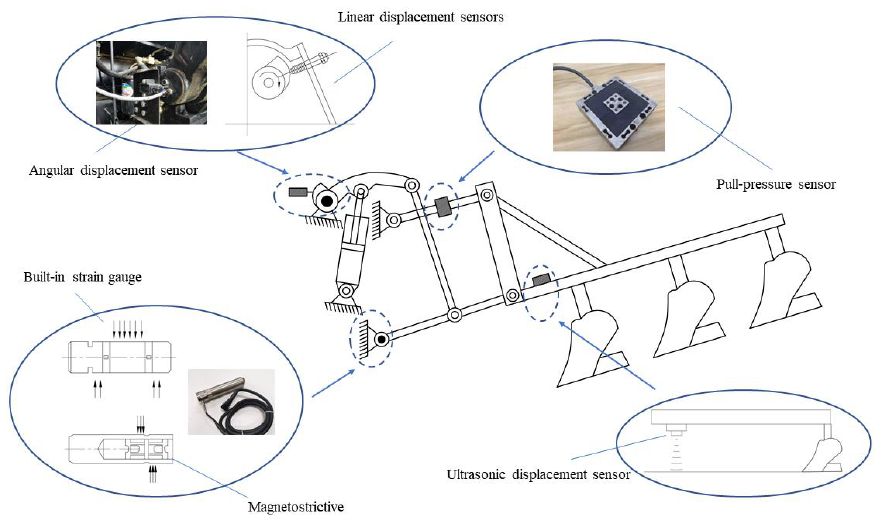
Figure 8. Schematic illustration of the installation of the sensors.